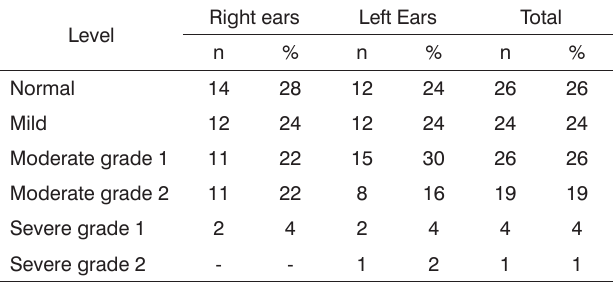
Table 5. Audiometric test results for right and left ears; patients in